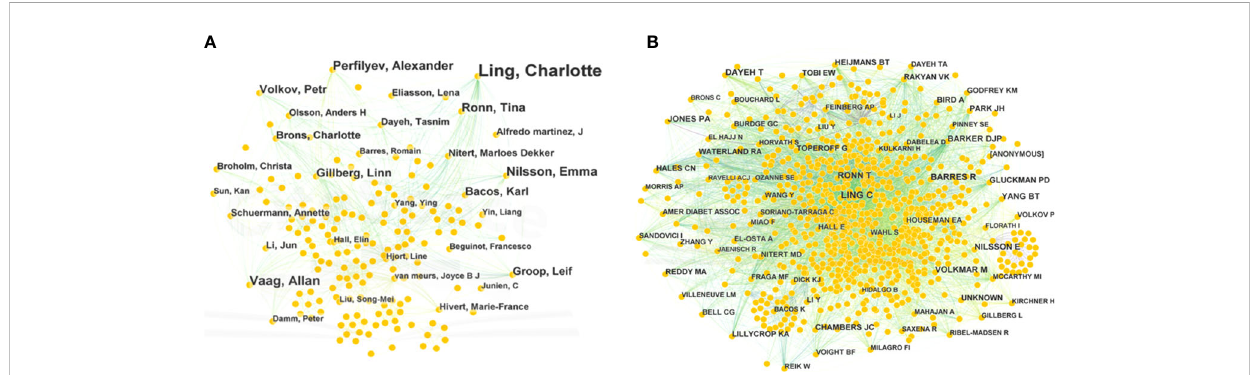
FIGURE 4 Bibliographic analysis of publication authors and cited authors. (A) Network of publication authors. (B) Network of cited authors. Different sizes denote the quantity of publications for authors or cited authors, and the distance between the two circles represents the relatedness between